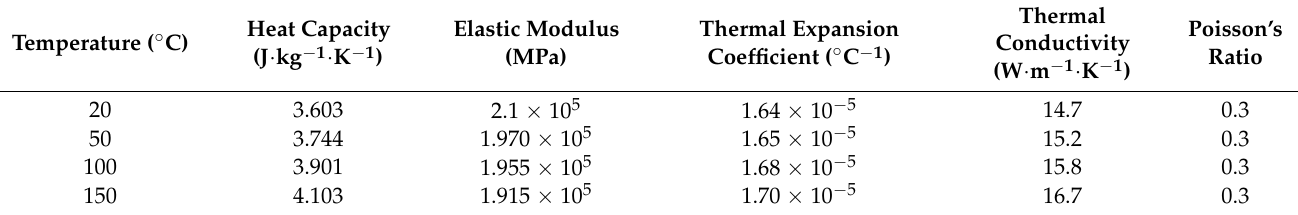
Table 2. Material model of